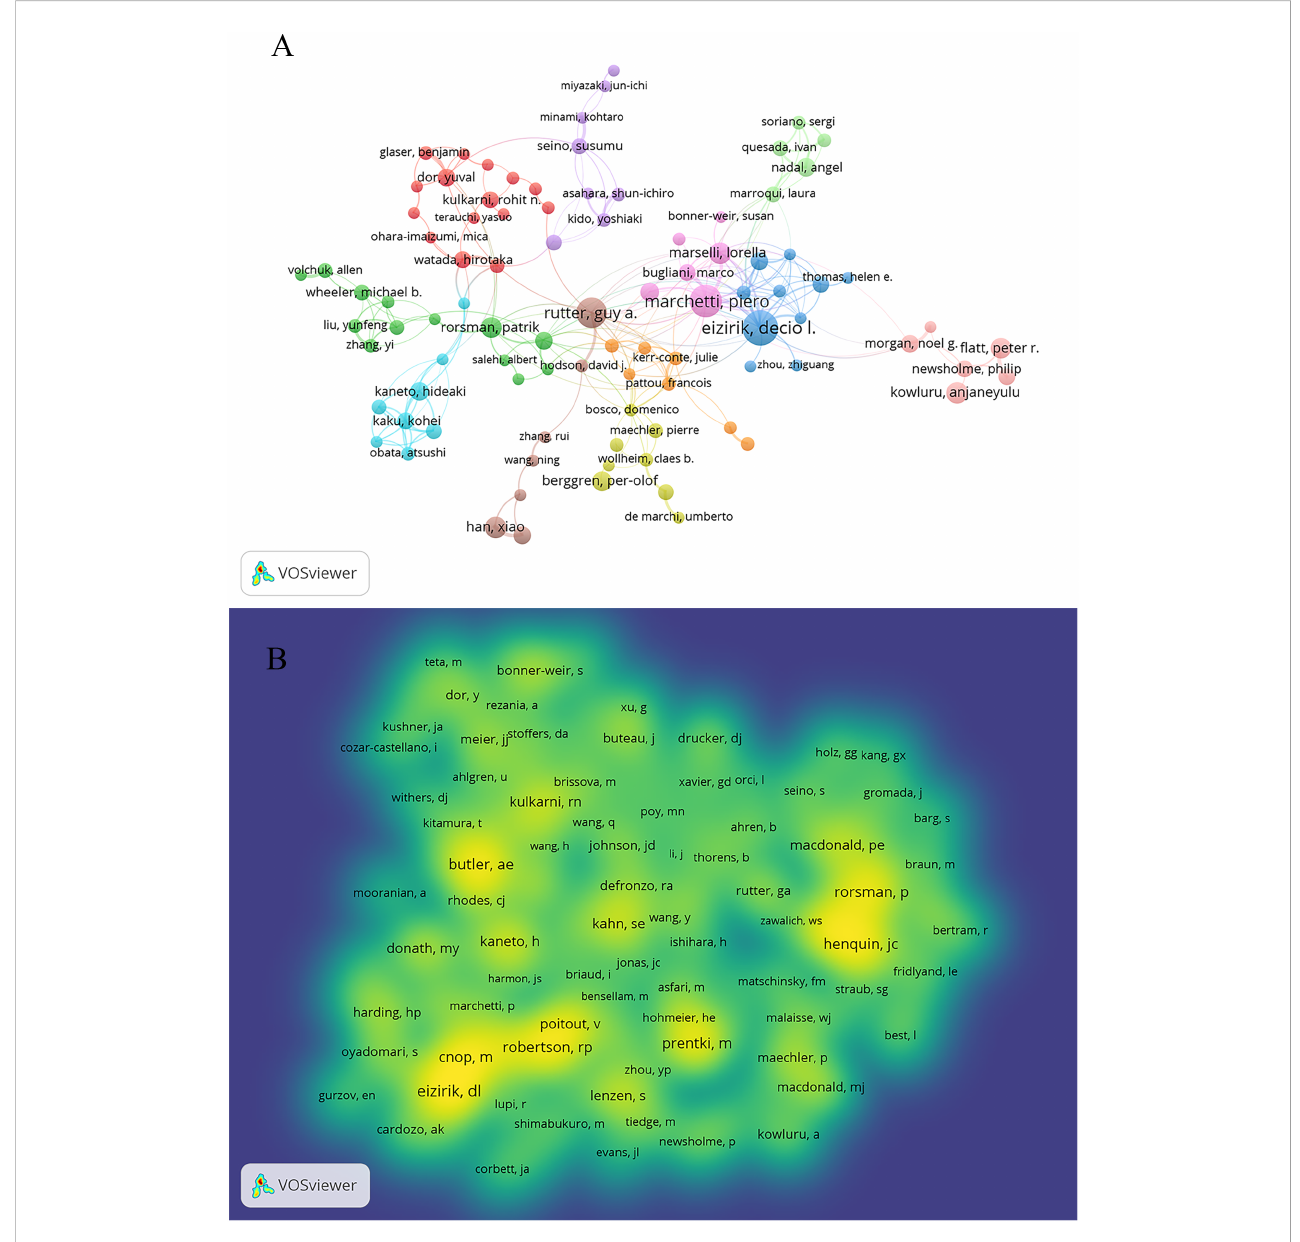
(B) The density map of co-cited authors. The layout parameters: Attraction: 2, Repulsion: 1. The color brightness means the frequency of